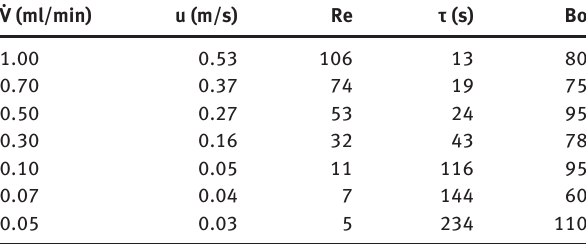
Table 2 Flow rates and Reynolds numbers applied for the characte- rization of the μ